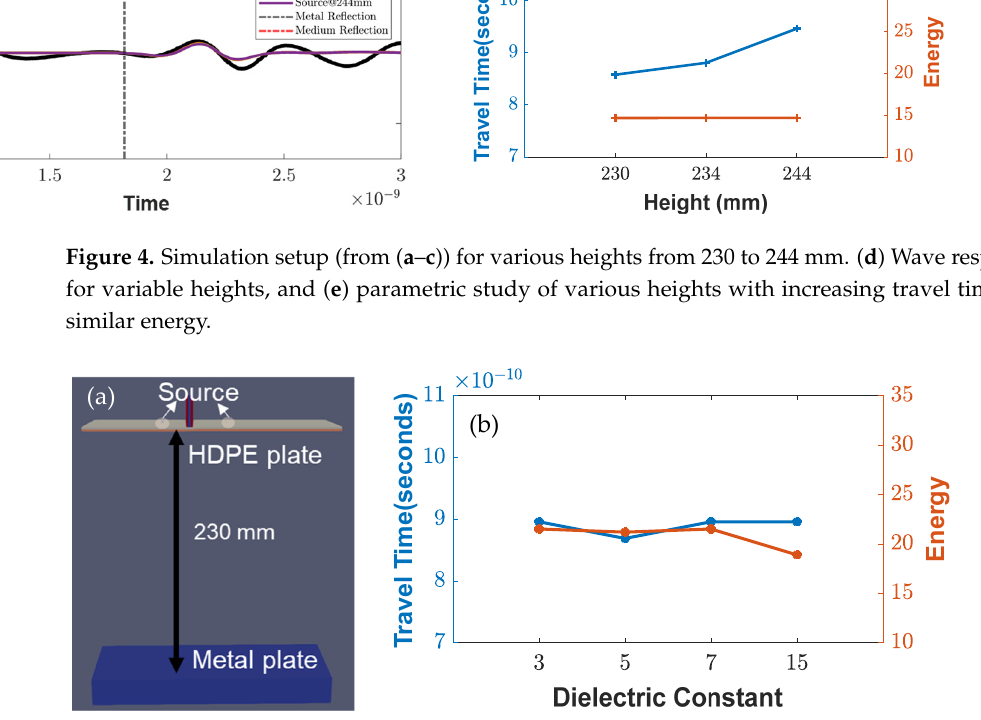
Figure 5. ( a ) Simulation setup for variable dielectric constants (3–15) considering a high-density polyethylene plate below the sensors, and ( b ) parametric study of various dielectric constants with similar travel times and energies.